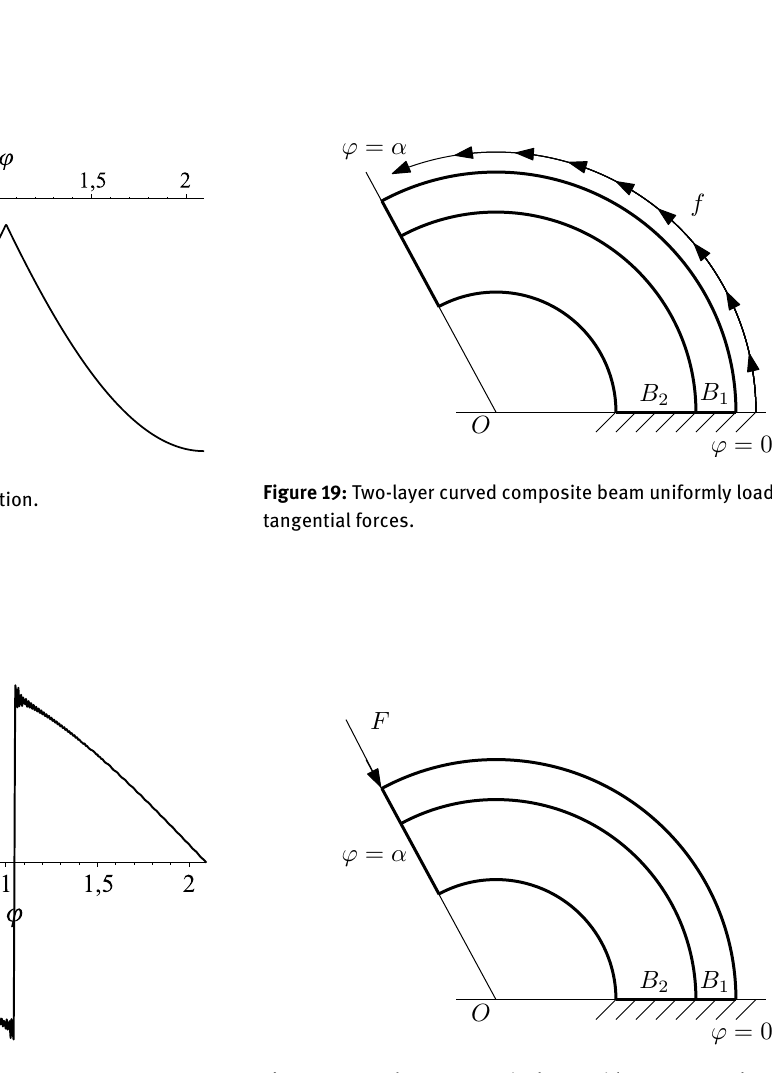
Figure 17: The graph of the shear force function.